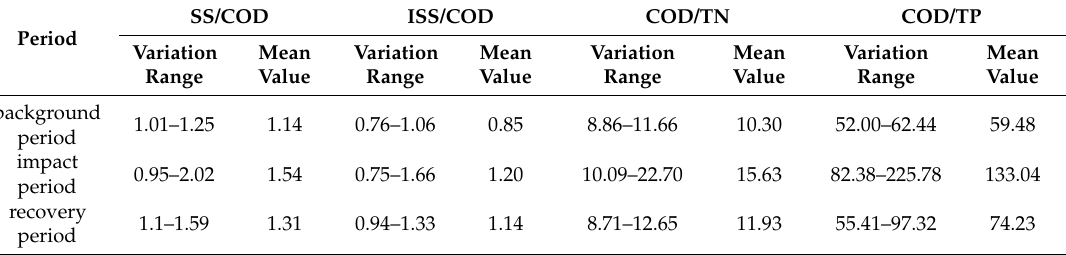
Table 3. SS/COD, ISS/COD, COD/TN, and COD/TP of grit chamber effluent.